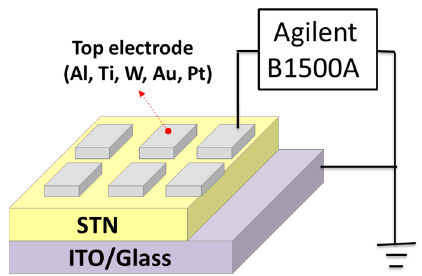
Figure 8. Device structure and measurement setup with Agilent B1500A.